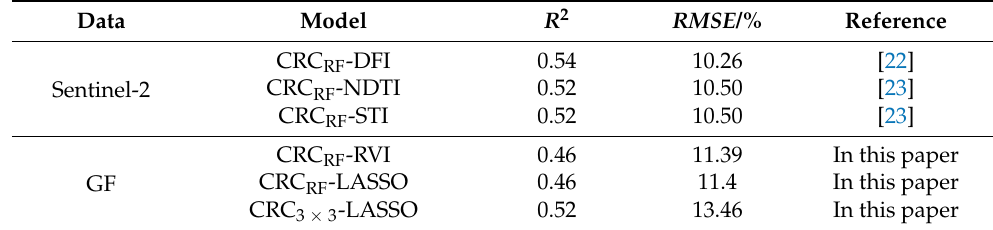
Table 5. Comparison of machine learning regression models for GF-1 and Sentinel-2 data.